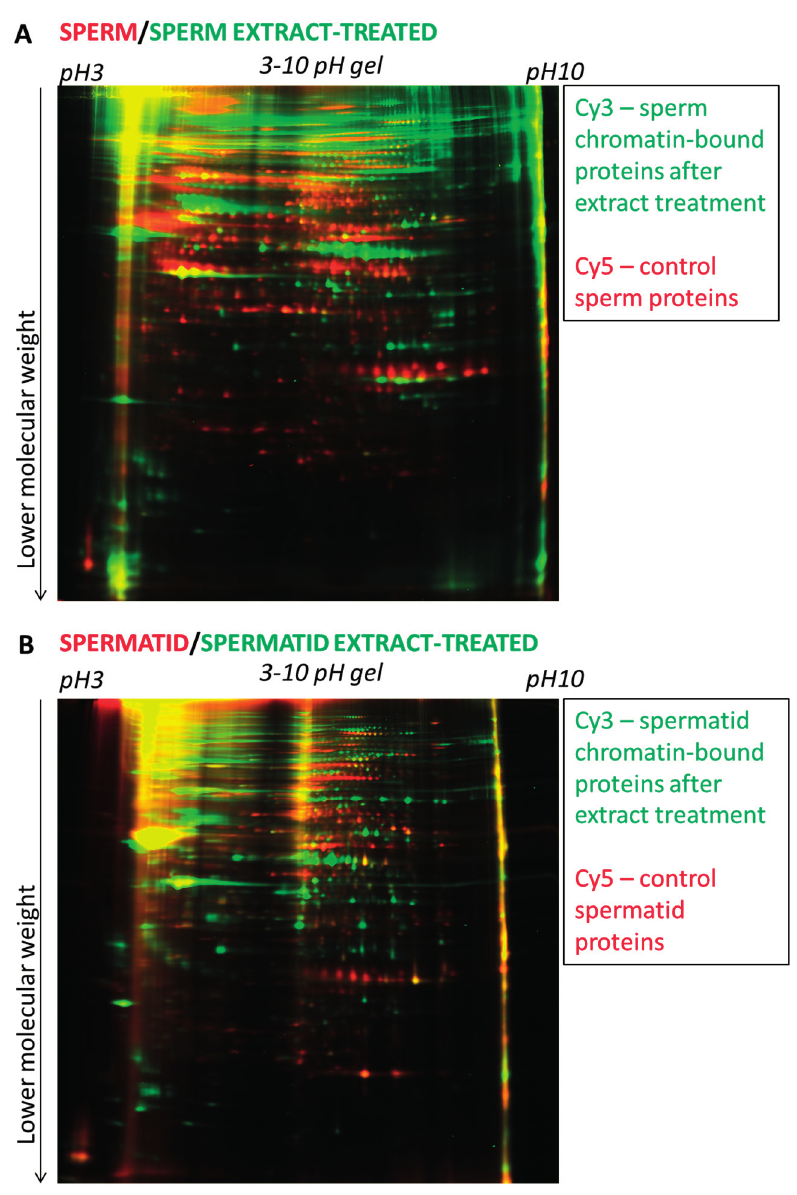
Figure 5. 2D-DIGE electrophoresis of proteins from sperm and sperm-extract treated and of spermatid and spermatid-extract treated. ( A ) Proteins isolated from sperm (red) were run on 2-D gel together with proteins bound to the sperm chromatin after egg extract treatment (green); ( B ) Proteins isolated from spermatid (red) were run on 2-D gel together with proteins bound to the spermatid chromatin after egg extract treatment (green). Note the presence of numerous red or green spots on both gels ( A , B ) and the low number of yellow spots. The first dimension electrophoresis for both gels shown was carried in the pH 3–10 (broad